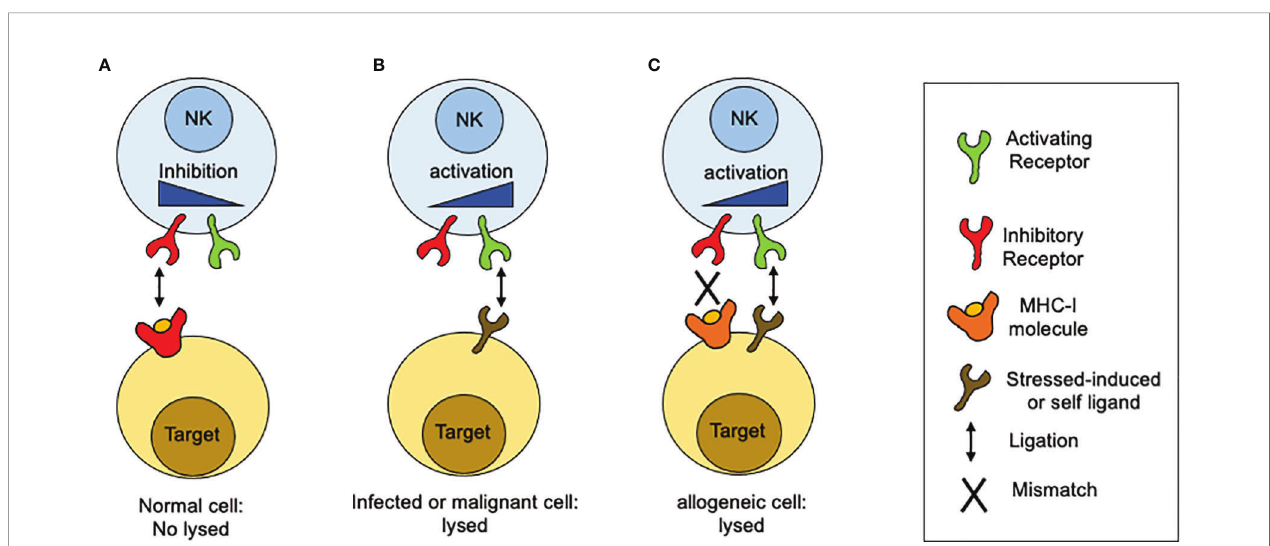
FIGURE 1 | How MHC-I molecules regulate NK cells reactivity. The idea of the missing-self was developed from different observations related with sensing MHC- class I molecules. (A) Normal or unstressed cells express MHC-I molecules which are recognized by inhibitory receptors expressed on the NK cell surface. When such receptors are engaged by MHC-I molecules, inhibitory signals are displayed. In the absence of ligation for activating receptors, the inhibitory signals predominate and target cells are not lysed. (B) When targets cells NK cells downregulate MHC class I expression, as consequence of viral infections or malignant transformation, inhibitory receptors are no longer engaged. In contrast, target cells start to upregulate the expression of surface molecules that are recognized by activating receptors. As consequence, activation signals are displayed unrestricted and target cells are lysed. (C) In the setting of allogeneic recognition, MHC class I molecules are expressed on target cells but are not recognized by NK cells as result of a mismatch. In consequence, activation signals proceed unrestricted and target cells are